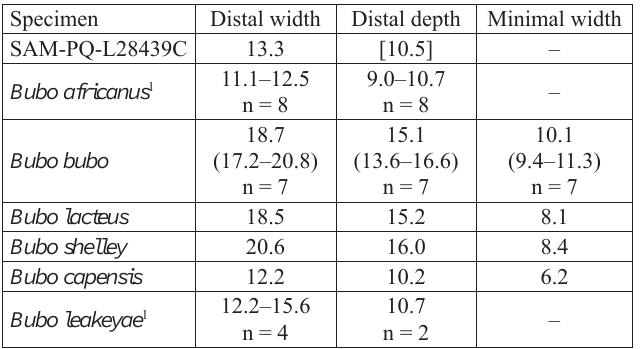
Table 9. Measurements (in mm) of the tibiotarsus of Bubo sp. from Langebaanweg in comparison with corresponding measurements of extant and extinct Bubo species. Measurements of slightly worn or damaged bones are given in square brackets. 1 measurements after Brodkorb and Mourer-Chauviré (1984); n, sample size.